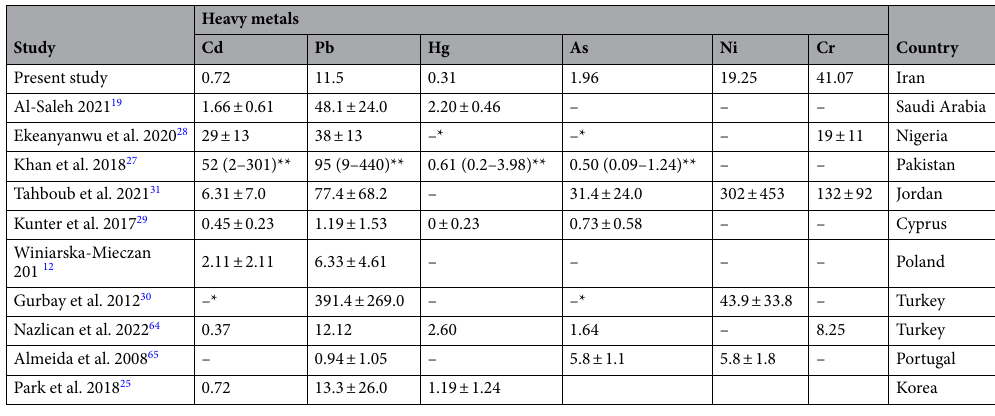
Table 3. Summary of literature findings of arsenic, lead, chromium, nickel, and cadmium levels (µg L -1 ) in breast milk. *below detection limits. **data presented mean